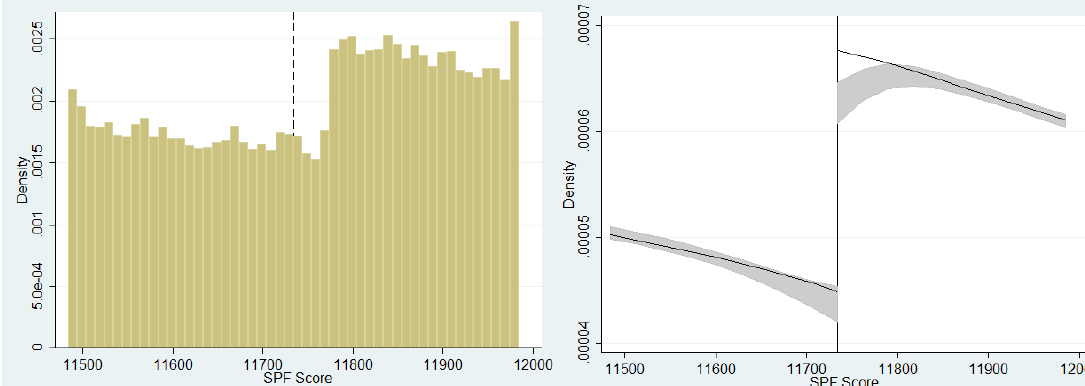
Figure 3: SPF Scores Distribution and Density Test near Subsidio Familiar Threshold